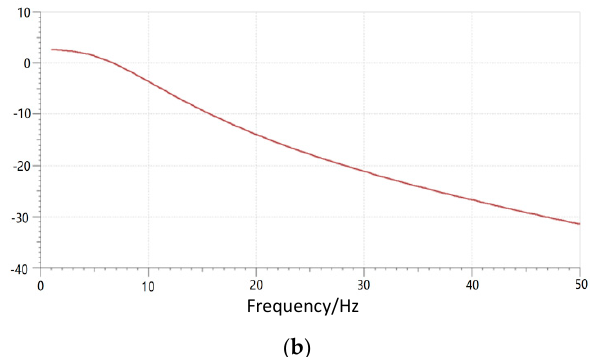
Figure 4. Low pass filter. ( a ) Circuit diagram of low pass filter. ( b ) Bode diagram of low pass filter.